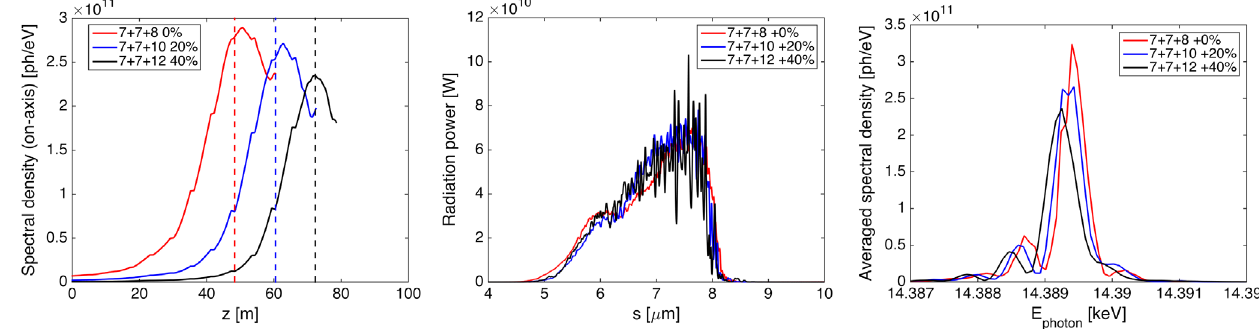
FIG. 10. Maximum on-axis spectral density versus position inside the last radiator (left). Radiation power (middle) and averaged spectral density (right) around saturation for the 7 þ 7 configuration and different emittance values. All plots refer to a single-shot event. The vertical dashed lines on the left plot show the position where the middle and right plots are plotted (the undulator modules are about 6.1 m-long), characterized by maximum on-axis spectral